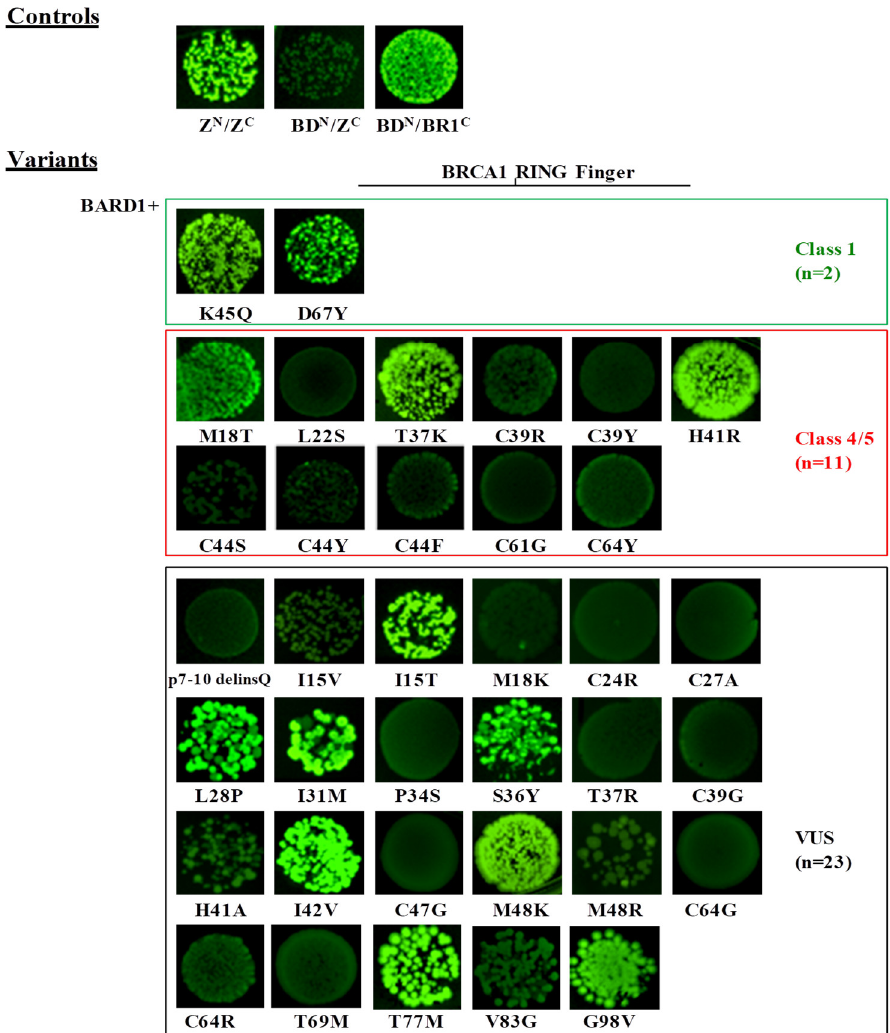
Figure 2. Detection of the BARD1/BRCA1 interaction by the GFP-fragment reassembly assay. Fluorescence was assessed after 24 h of growth at 30 °C followed by 2 days of incubation at RT. All pictures were taken with the same setting of digital camera (long-wave UV light, 365 nm). [Z N , H 6 -NfrGFPZ, Z C , ZCfrGFP, BD N , H 6 -NfrGFPBARD1, BR1 C , BRCA1CfrGFP].